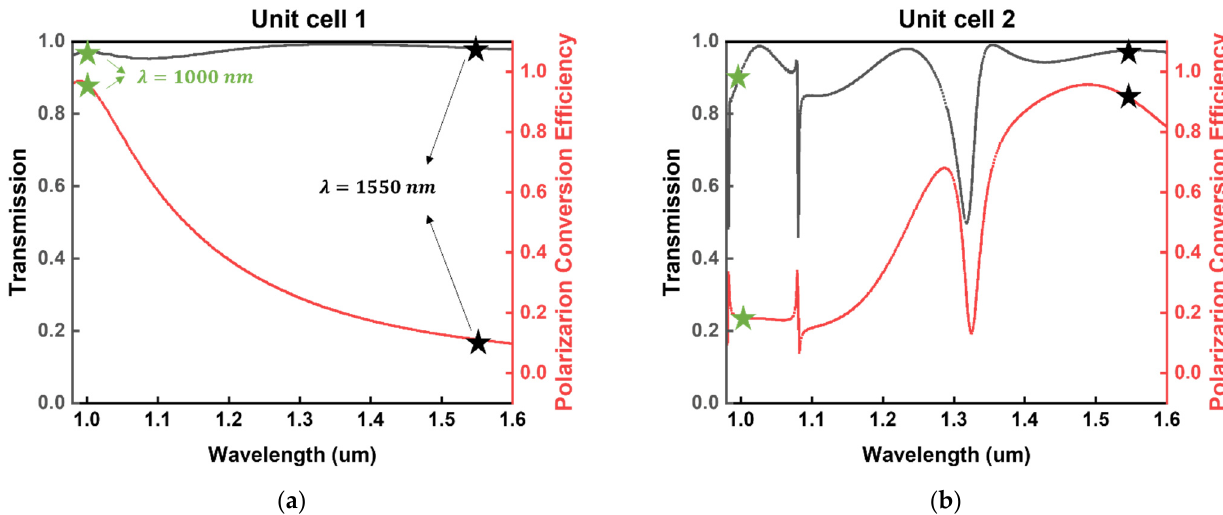
Figure 2. The transmission and PCE of the unit cell 1 ( a ) and unit cell 2 ( b ) with wavelengths ranging from 0.98 µm to 1.6 µm. Transmission and PCE are highlighted with green stars for 1000 nm and black stars for 1550 nm, respectively.